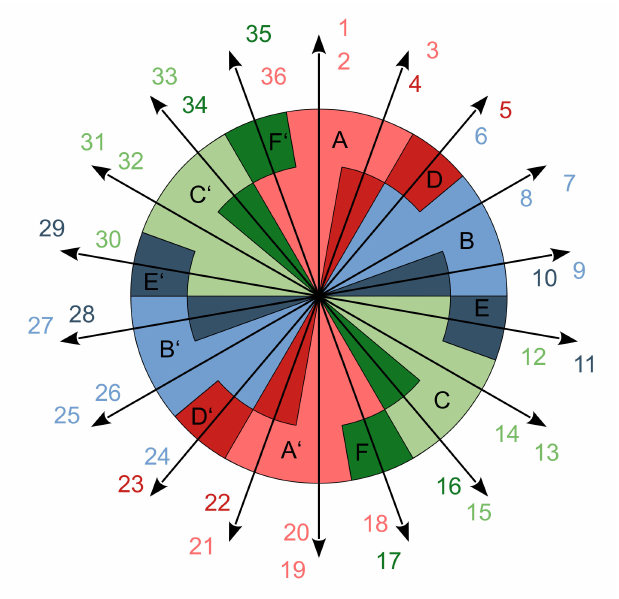
Figure 4. Star of slot phasors, numbered coil sides, and colored phase belts of six-phase winding with q = 3/2 and winding step y 1 s =